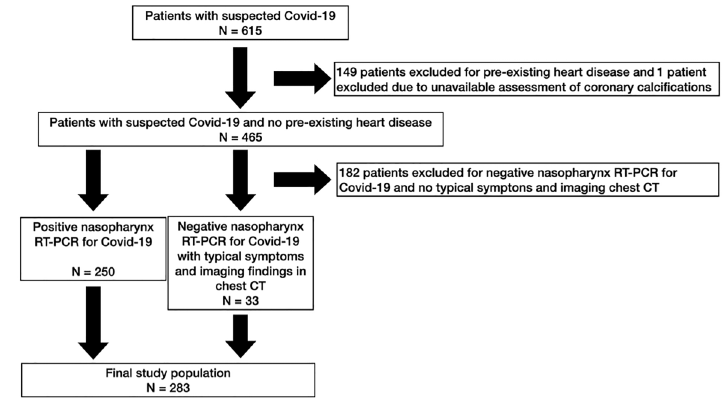
Figure 1. Flow diagram of participants in the